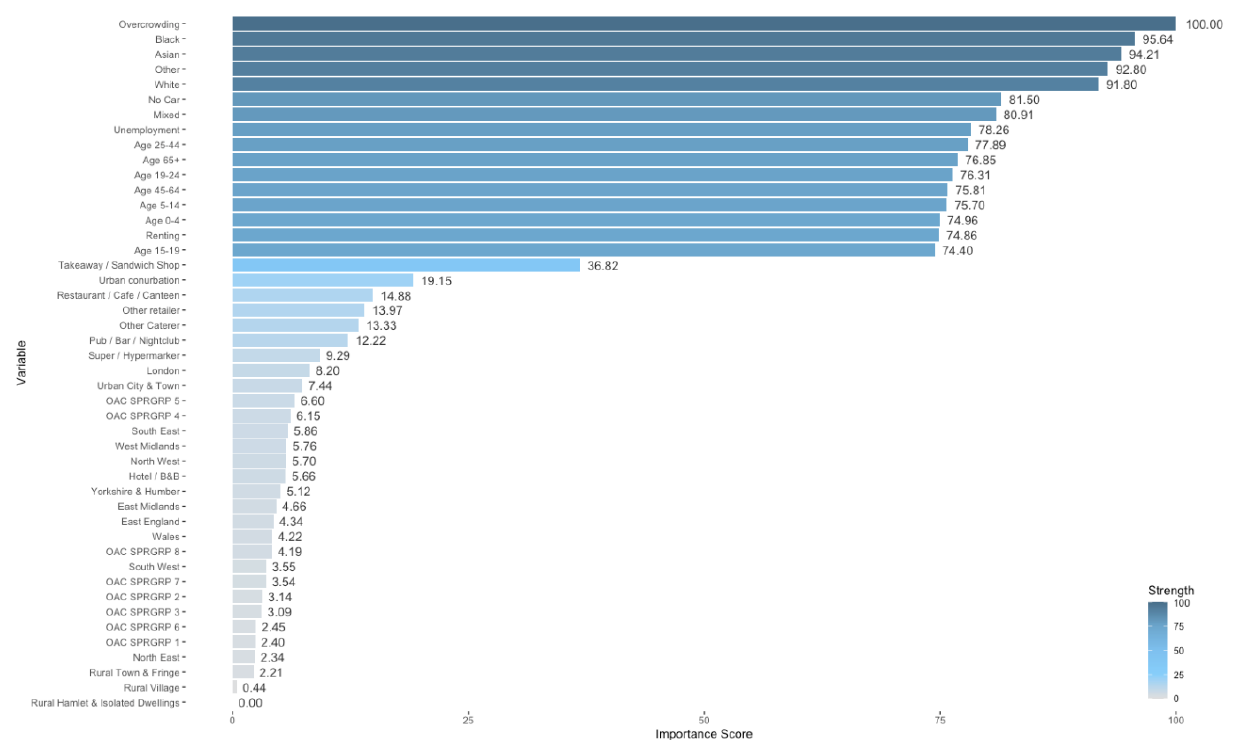
Figure 3. Variable importance scores for SMOTE random forest set 1 where red variables have higher predictive strength and blue variables have lower predictive strength.